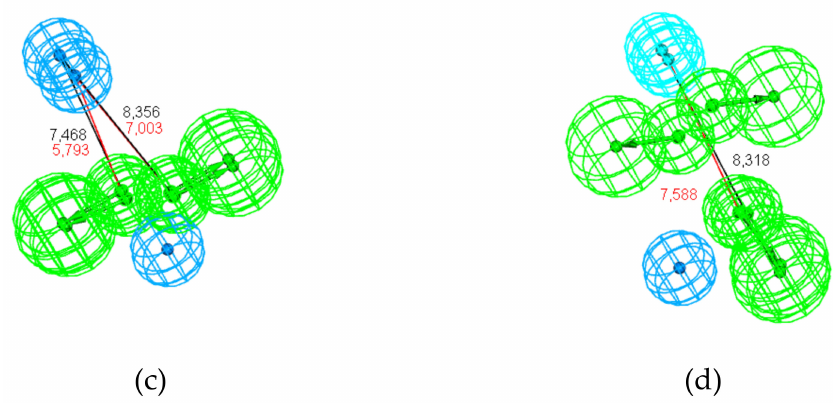
Figure 10. Pharmacophore mapping of the closest hypotheses according to cluster analysis. ( a ) Hypo1_t-PNA and Hypo1_STR-PNA (distances between Hypo1_t-PNA features are shown in black, and distances between Hypo1_STR-PNA features are shown in red); ( b ) Hypo1_STR-CAR and Hypo1_EXP (distances between Hypo1_STR-CAR features are shown in black, and distances between Hypo1_EXP features are shown in red); ( c ) Hypo1_STR-PNA and Hypo1_EXP (distances between Hypo1 STR-PNA features are shown in black, and distances between Hypo1 EXP features are shown in red); and ( d ) Hypo1_t-STR and Hypo1_t-CAR (distances between Hypo1 t-STR features are shown in black, and red distances between Hypo1_t-CAR features are shown in